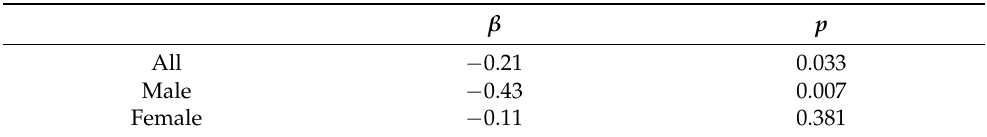
Table 3. Multiplicative interaction results between dietary iron intake and SNP rs516946 among participants 1 .